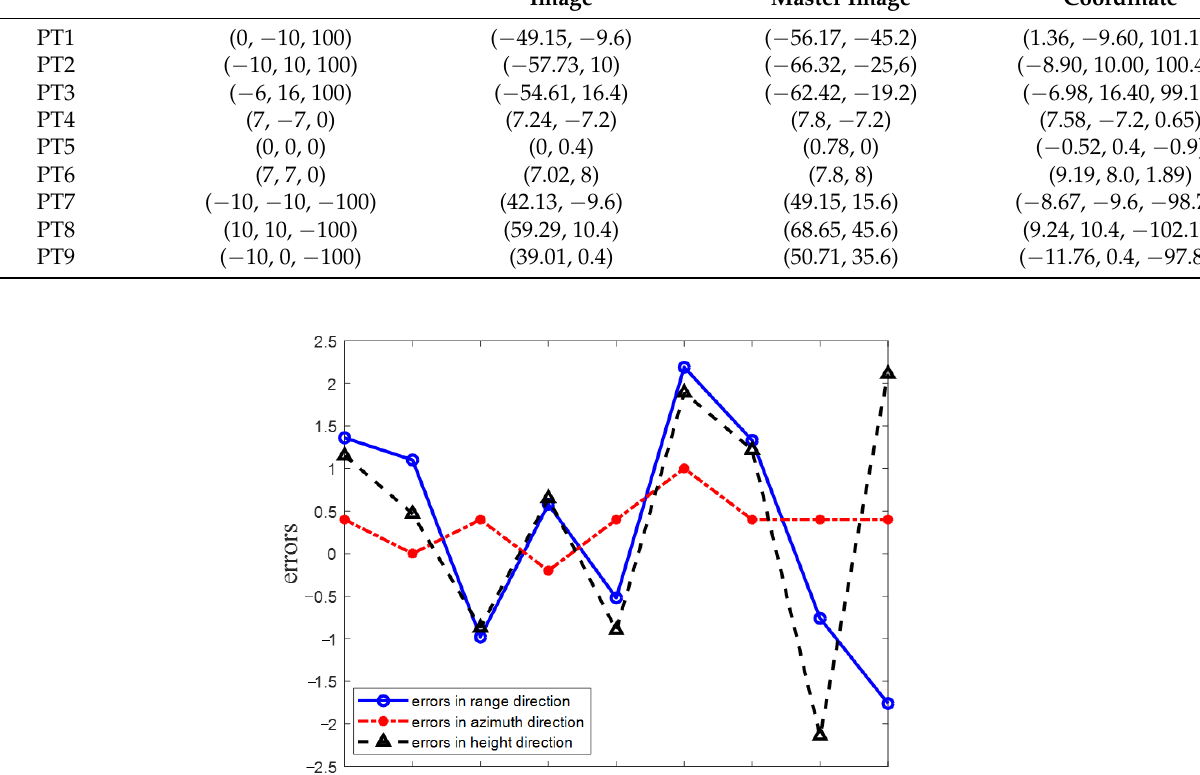
Figure 10. Result after image pair registration. Table 2. Coordinate extraction results of nine PTs.